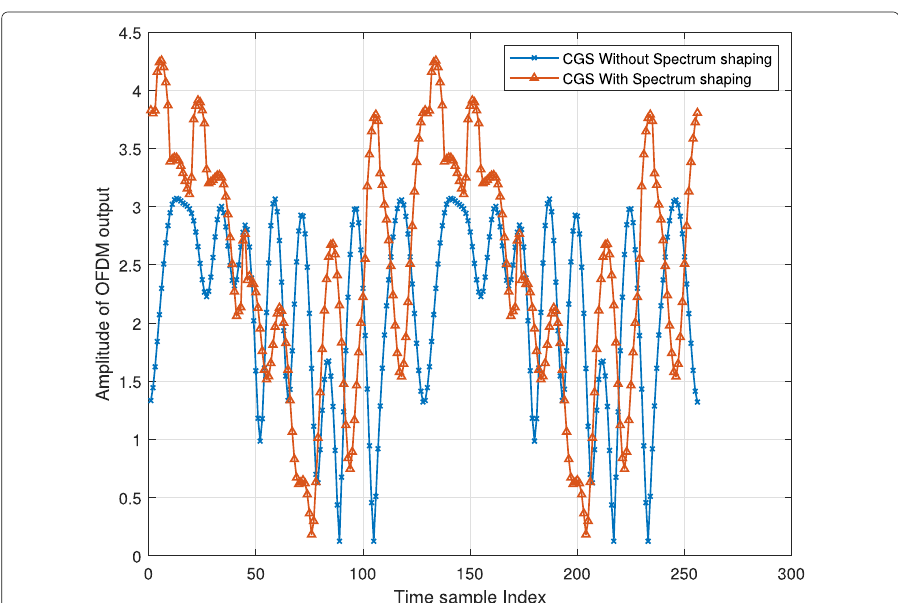
Fig. 16 Magnitude response of CGS sequences with and without spectral shaping